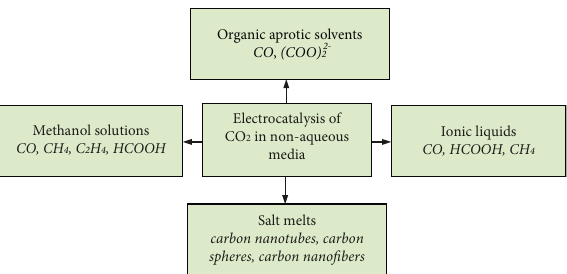
2 conversion in